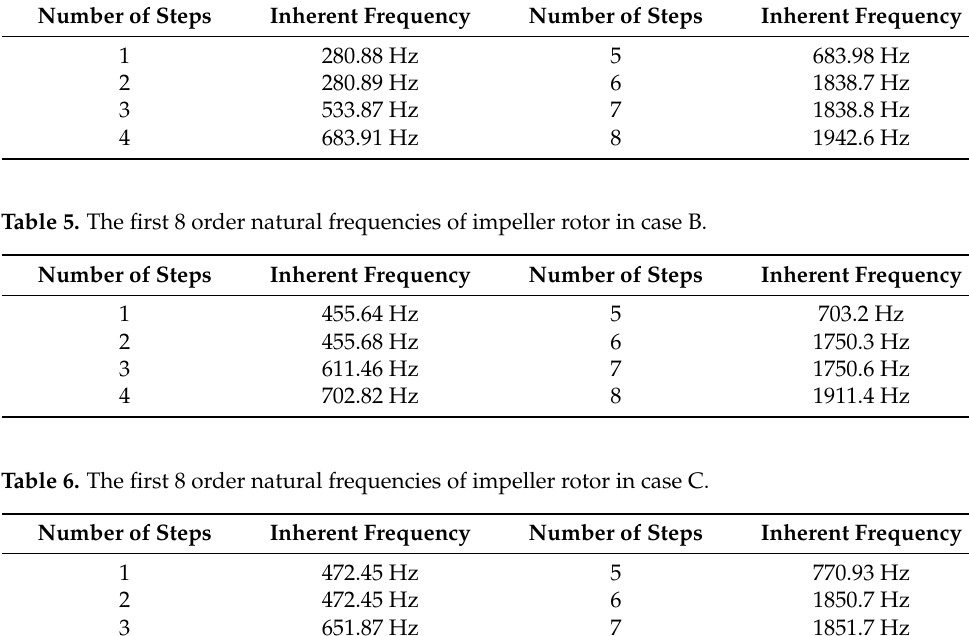
Table 4. The first 8 order natural frequencies of impeller rotor in case A.